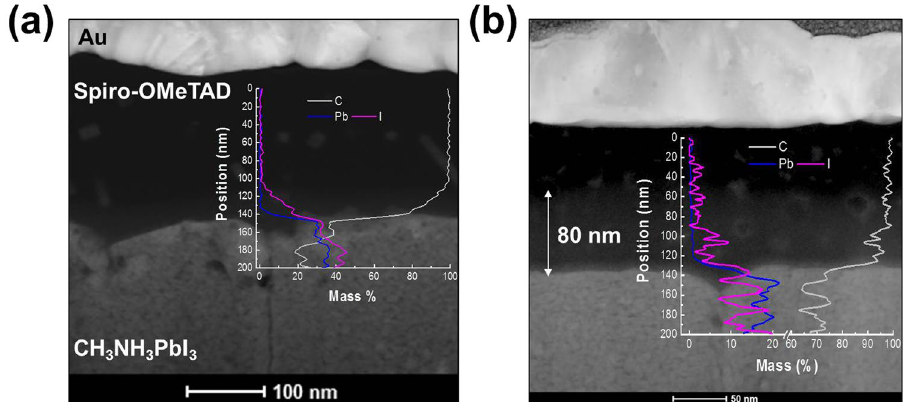
Figure 4. High-angle annular dark-field (HAADF) scanning transmission electron microscopy (TEM) images showing cross-sectional views of the MAPbI 3 /spiro-OMeTAD interface: ( a ) pristine and ( b ) thermally stressed at 85 °C for 2 h. Inset shows EDX line maps for lead and iodine. Contrast images and EDX display the presence of